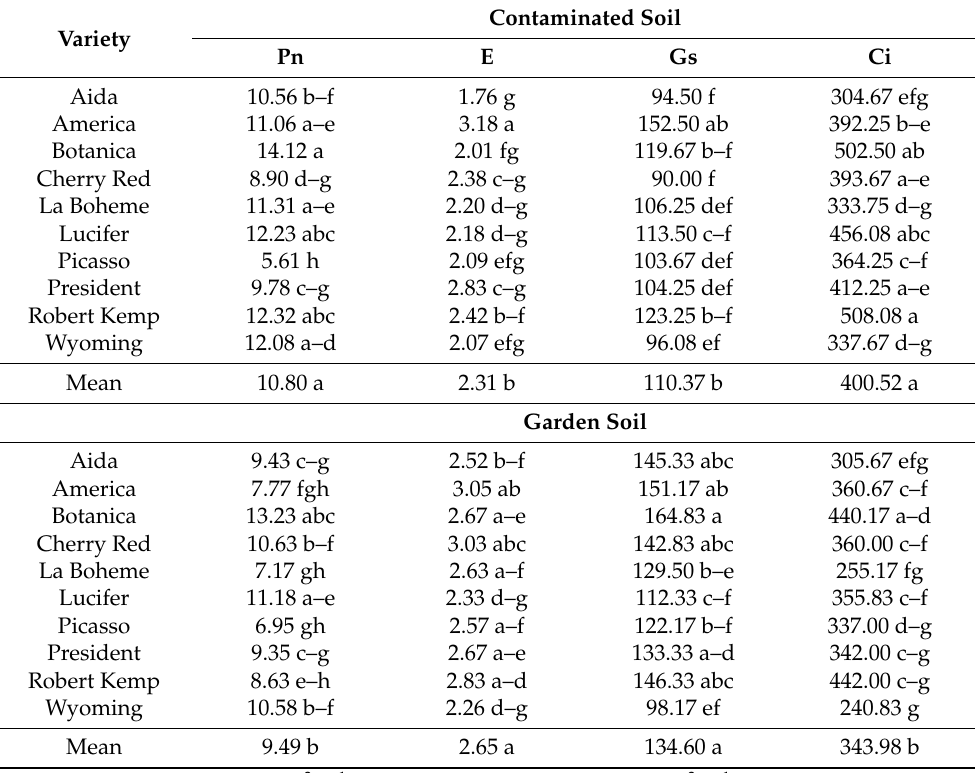
Table 2. The photosynthesis intensity and gas exchange parameters of the canna at various cultivation